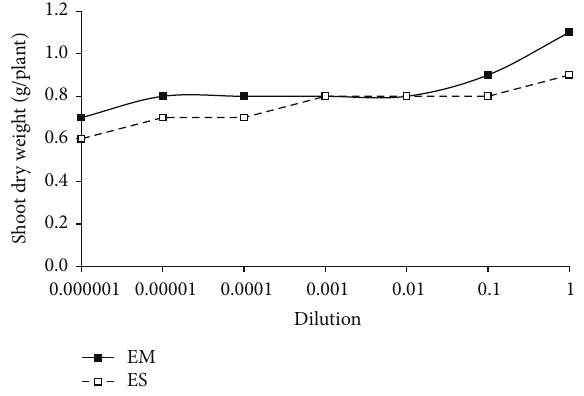
Figure 3: Shoot dry weight of P. patula seedlings as a function of EM and ES inoculation at each level of serial